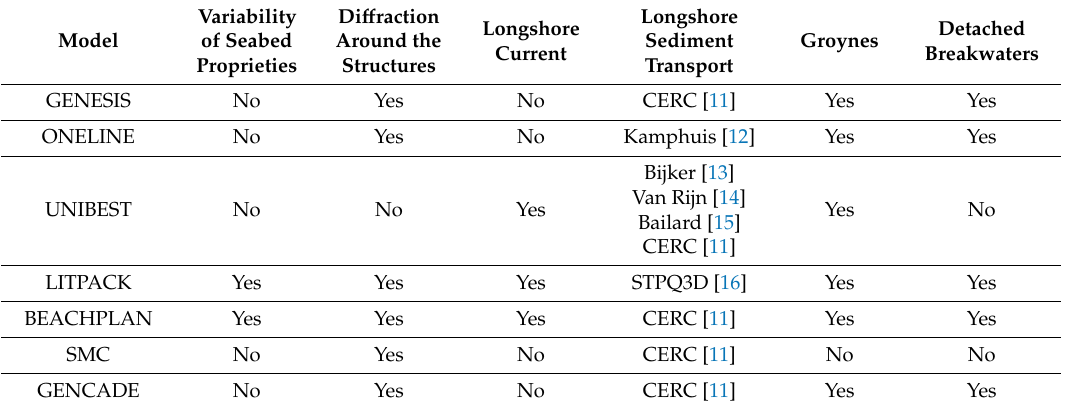
Table 1. Main features of the existing one-line